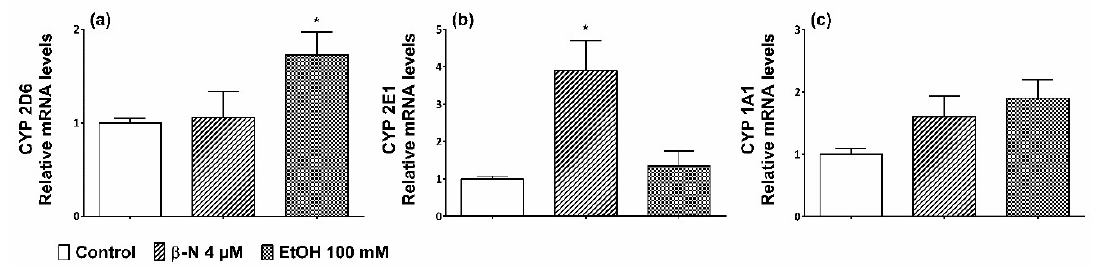
Figure 1. mRNA levels of CYP2D6, 2E1, and 1A1 in SH-SY5Y cells treated with β -naphtoflavone ( β -NF) and EtOH. The relative mRNA levels were measured by qRT-PCR for CYP 2D6 ( a ), CYP 2E1 ( b ), and CYP 1A1 ( c ). The results represent the mean ± SEM of at least three different experiments. Each column represents the fold increase calculated after a ∆∆ C t analysis of each treatment compared with controls and normalised with rRNA 18S as a housekeeping gene. Controls of each isoform were always taken as 1-fold increase. * p < 0.05 vs. control.